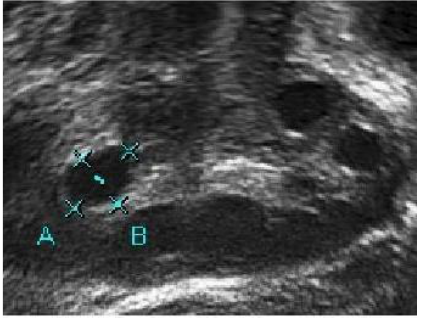
Figure 4. Ultrasound image with high intensity of dark pixels.